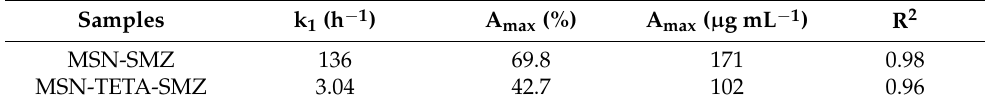
Table 4. Kinetic parameters for SMZ release from MSN and